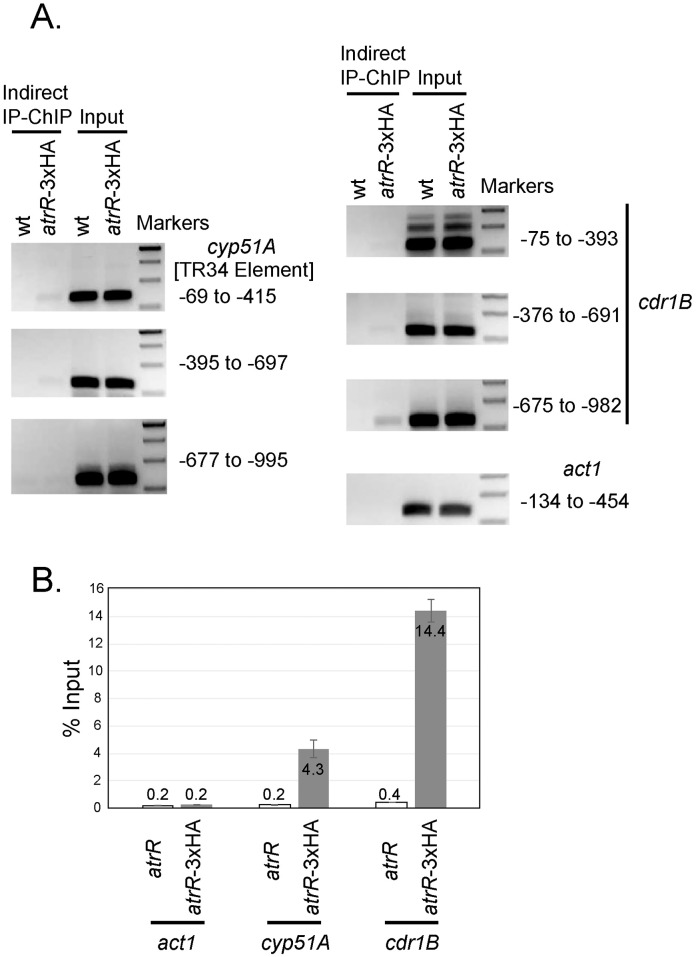
Chromatin immunoprecipitation assay showing binding of AtrR protein to the promoter regions of cyp51A and cdr1B.(A) Chromatin immunoprecipitation (ChIP) was done using a mouse monoclonal antibody directed against the HA epitope. Crosslinked chromatin was prepared from a WT strain or an isogenic strain expressing a 3x HA-tagged form of atrR (shown as atrR-3× HA). Immunoprecipitated DNA was examined by semiquantitative RT PCR analysis using primers that amplified the cyp51A and cdr1B promoters. The relative enrichment of the act1 promoter was also assessed as a control for a promoter not responsive to AtrR. (B) Quantitative analysis for enrichment of the cyp51A and cdr1B promoters by real-time RT PCR method. Chromatin immunoprecipitated from the atrR-3× HA strains exhibited a 20-fold enrichment of cyp51A promoter DNA along with a ~33-fold enrichment of cdr1B promoter sequence. No detectable enrichment of act1 was found. Data are presented as the mean and standard error of two separate ChIP experiments. % input represent signals obtained from the ChIP that are divided by signals obtained from the input sample.